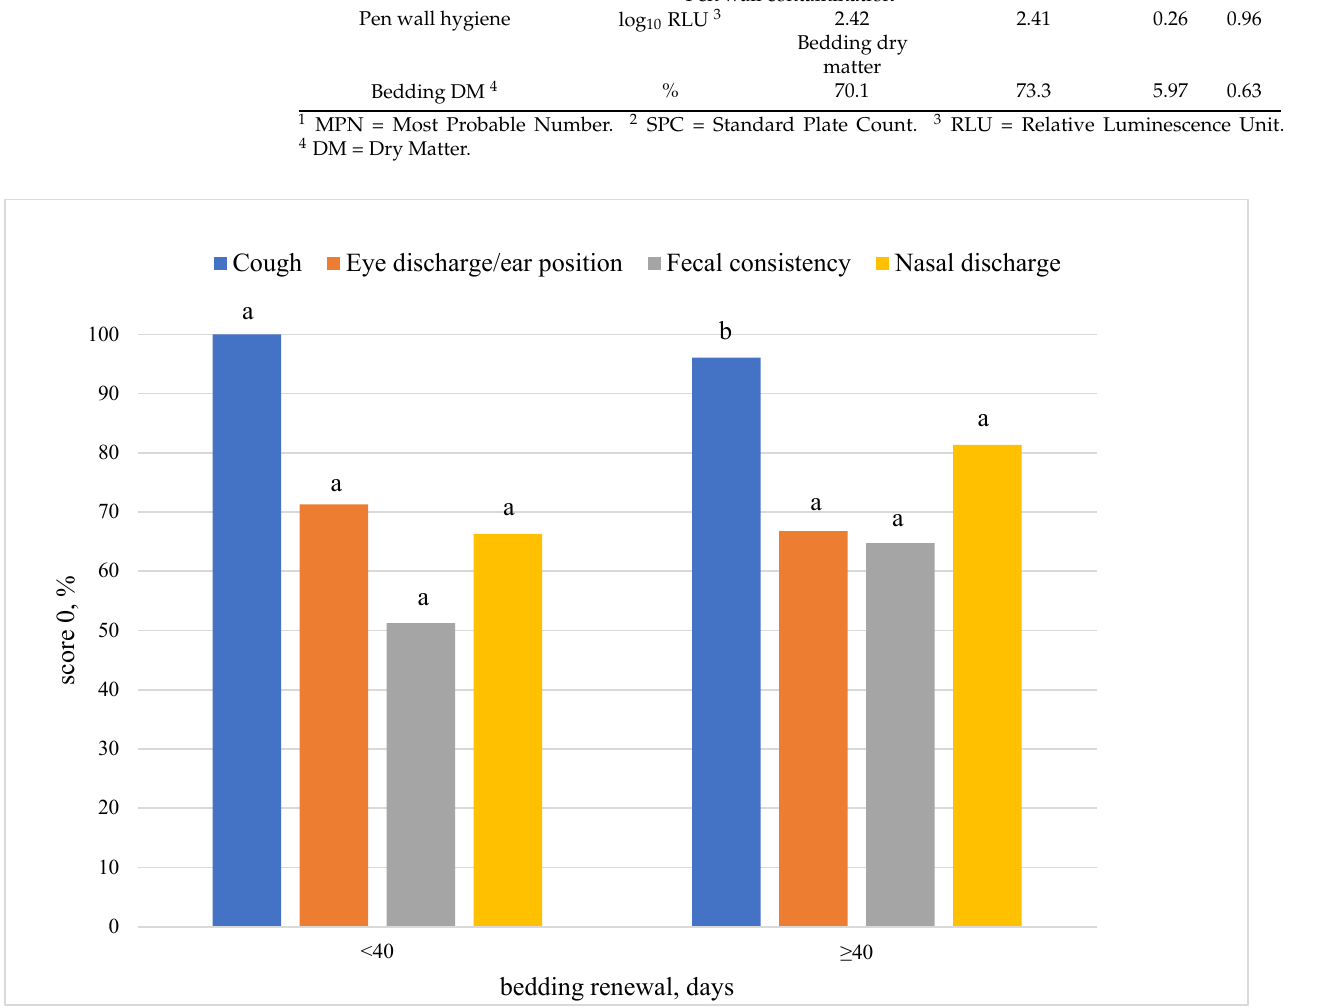
Figure 1. Effect of frequency of bedding renewal on calf health scores. Score 0 corresponds to normal condition. Different letters between bars of the same colour mean p < 0.05.